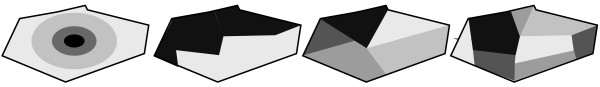
The intra-urban scale: patterns of spatial organization.